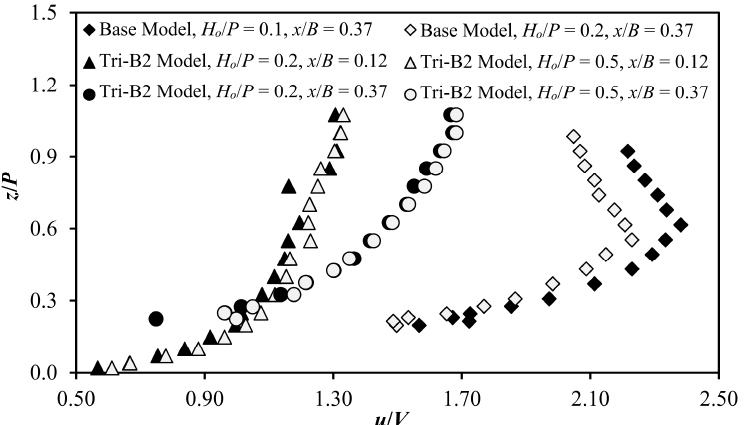
Figure 7. Velocity profiles in the inlet key centerline of the base model: ( a ) dimensional value; ( b ) dimensionless value. ( V = 0.139 and 0.293 m/s for H o / P = 0.1 and 0.2, respectively).